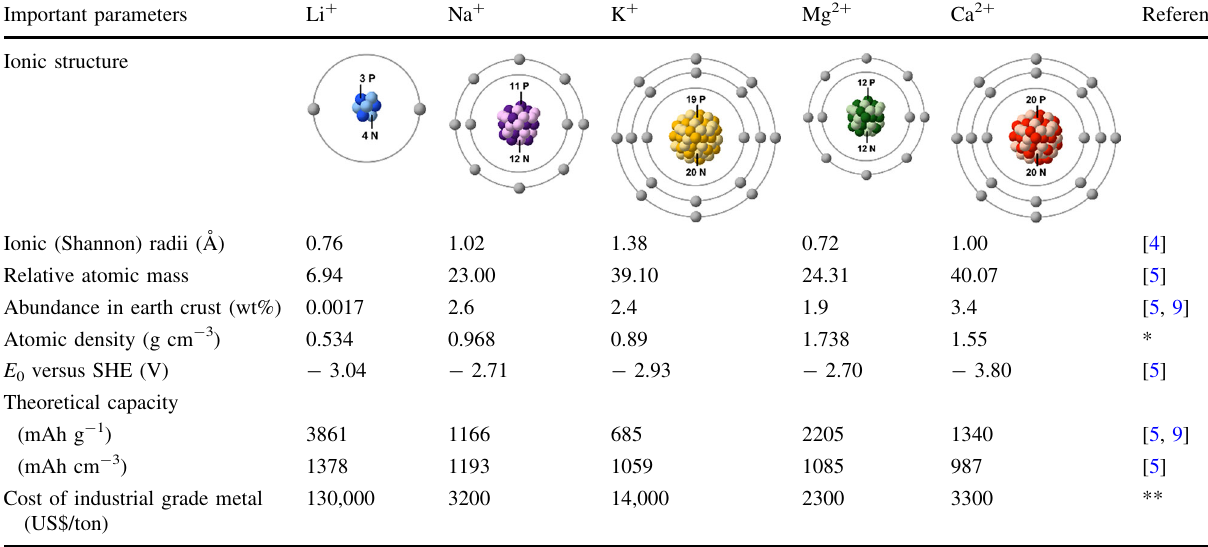
Table 1 Comparison of the critical parameters of Li with other important metal ions that are used in emerging metal ion rechargeable electrochemical storage devices. These parameters play an important role in determining the choice of raw material Important parameters Li ? Na ? Mg 2 ?